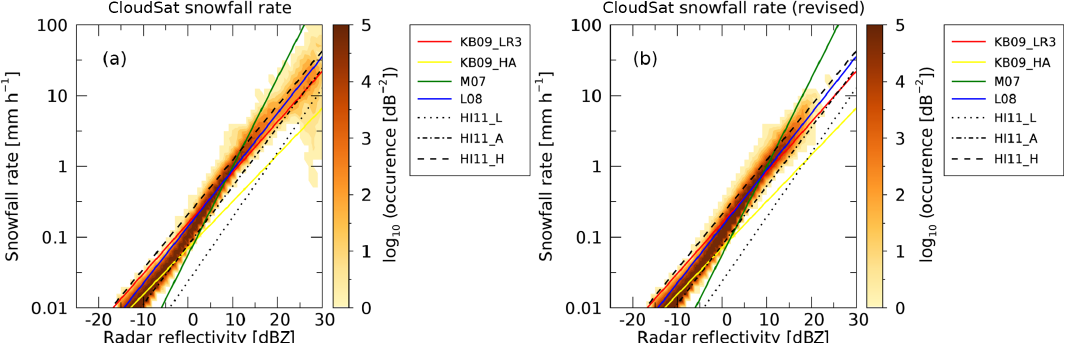
Figure 4. Histogram of occurrence of snowfall rate versus radar reflectivity for the entire CloudSat dataset over Greenland. Panel (a) shows the relation if the SNOWPROF surface snowfall rate is used as provided in the original SNOWPROF product. Panel (b) shows the relation with corrected topography. Different Z – S relations are shown as